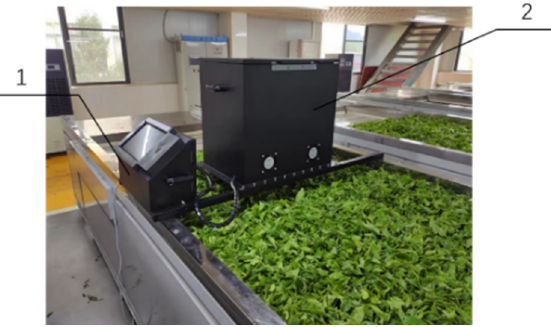
Figure 2. Structural diagram of the Yinghong No. 9 tea leaves moisture content detection system: